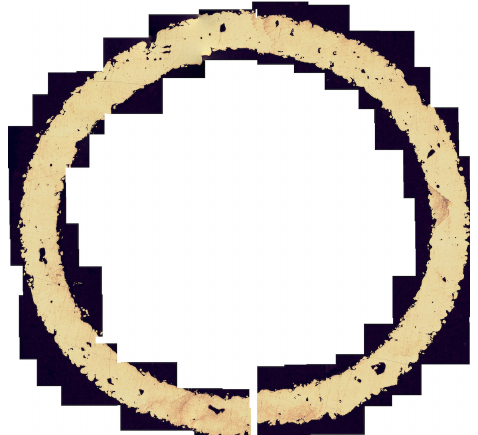
Figure 13. Porosity in a 1.2 specimen transversal section due to low energy density.